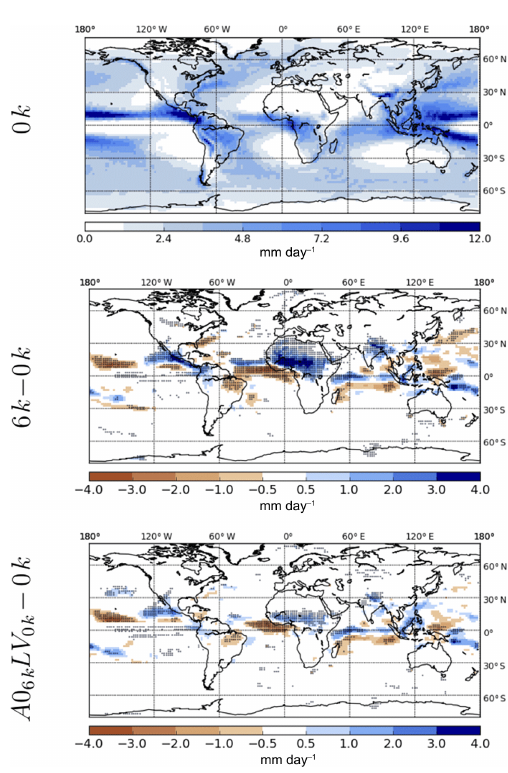
Figure B1. Mean annual precipitation for 0 k and for the differences 6 k –0 k and A0 6 k LV 0 k − 0 k . Hatched areas in the difference plots show significant precipitation differences (99% confidence level) according to a Student’s t